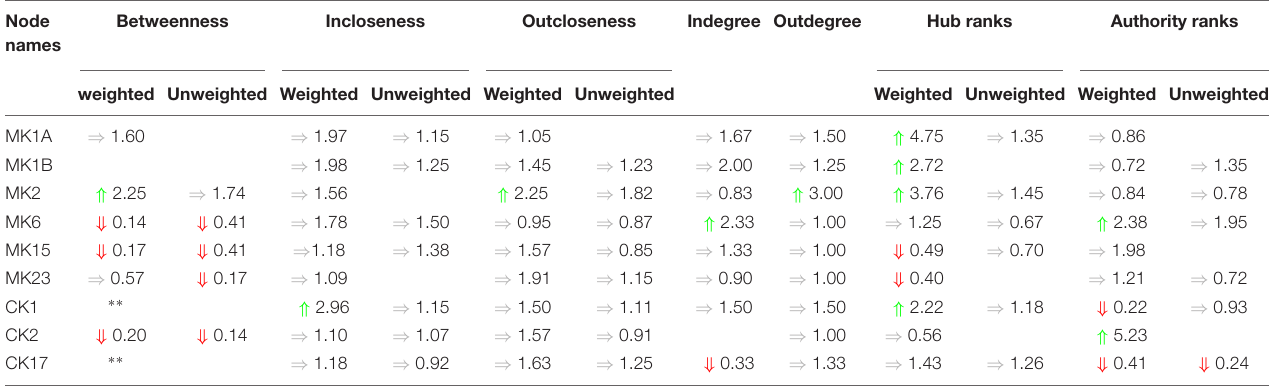
TABLE 4 | Summary of changes in cytokine node centrality.